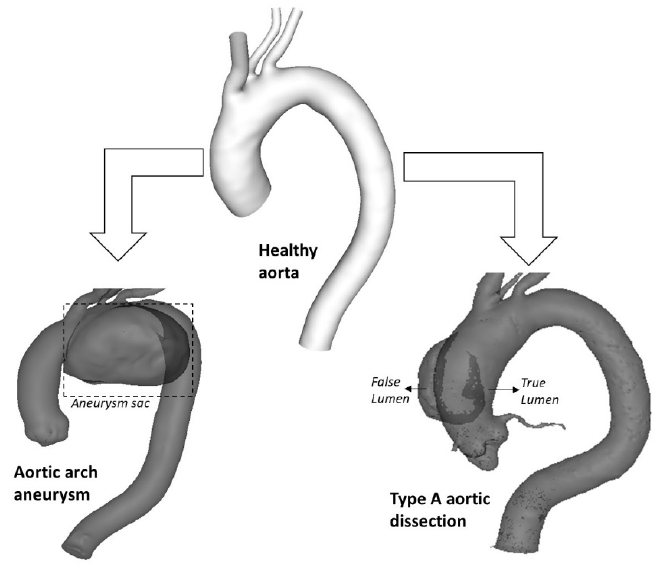
Figure 1. Schematic illustration of common aortic diseases in the ascending aorta and aortic arch.